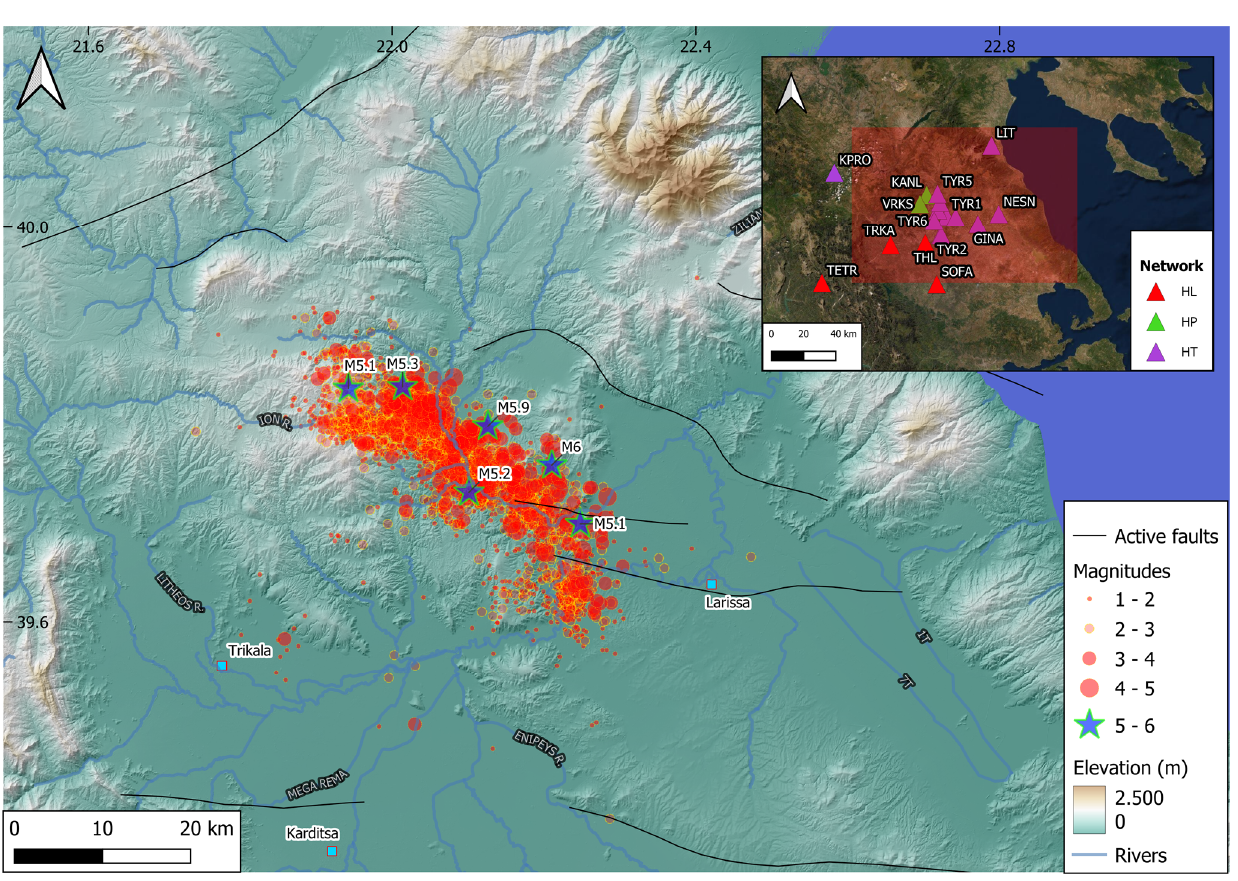
Figure 4. Black lines correspond to the main active faults for the study area—a general seismicity map of the broader area of the Thessalian, Central Greece. Light blue rectangles denote the cities of the study area. The stars represent the events in the study area for 3 March 2021–31 December 2021.